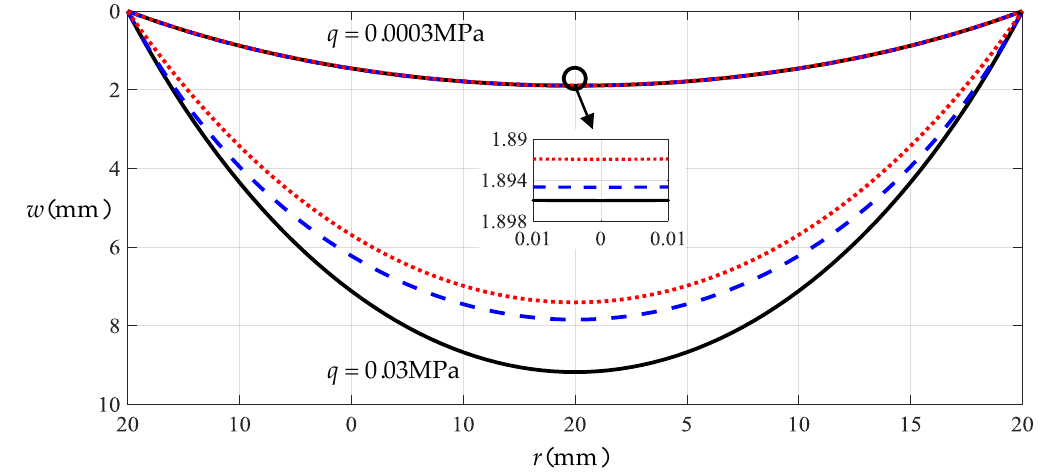
Figure 3. Variation of w with r when q takes 0.0003 MPa and 0.03 MPa.